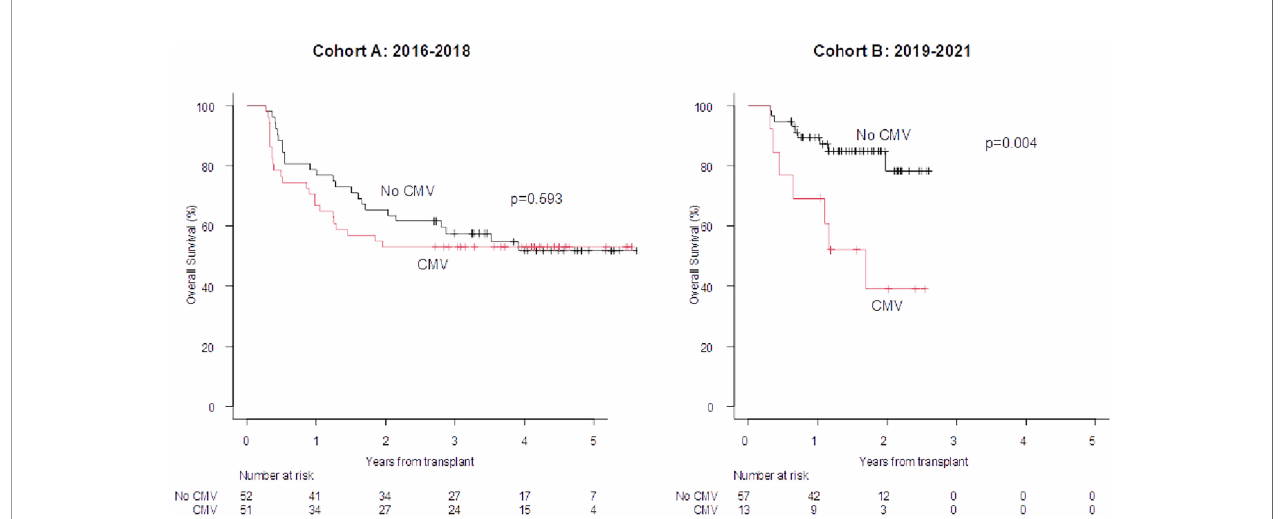
FIGURE 4 | 100-days Landmark OS according to the development of CMV reactivation by day +100 (any level of DNA). OS at 1 and 2 years in case of CMV infections at +100 days vs no event (cohort A): 66.7% 78.8% and 52.9% vs 65.4%. OS at 1 and 2 years in case of CMV infection at +100 days vs no event (cohort B): 69.2% vs 89.3% and 38.9% vs